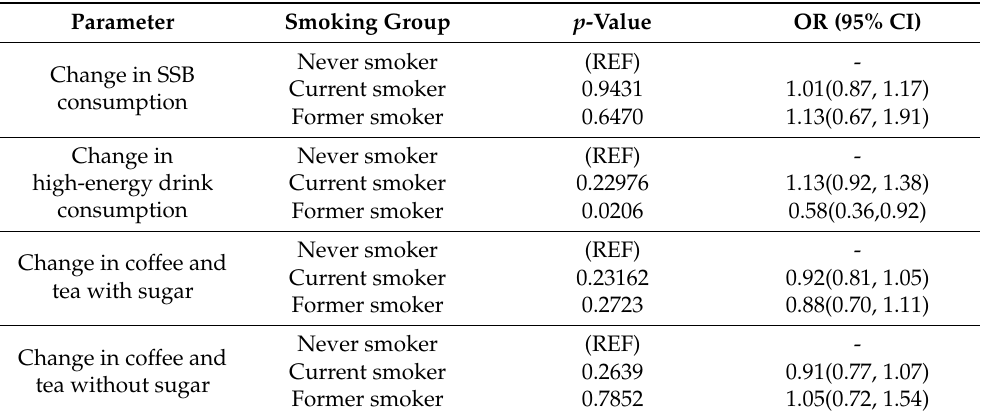
Table 7. Model 3: Longitudinal association between change in beverage consumption (2016/17– 2017/18) and never smokers, current smokers, and former smokers in 2017/2018 in the COM- PASS study.